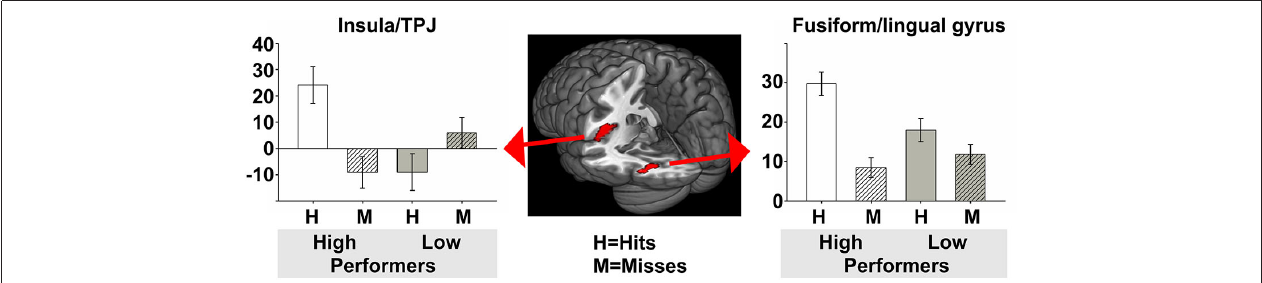
FIGURE 4 | Parameter estimates for the two activated clusters. To further illustrate group differences between HP and LP, this figure depicts the parameter estimates including 90% confidence intervals, for hits and misses, for both the HP and the LP group. In both clusters resulting from the contrast HP > LP for hits > misses the HP group had more activity for hits than for misses, and more activity for hits than the LP group. HP, high performers; LP, low performers .